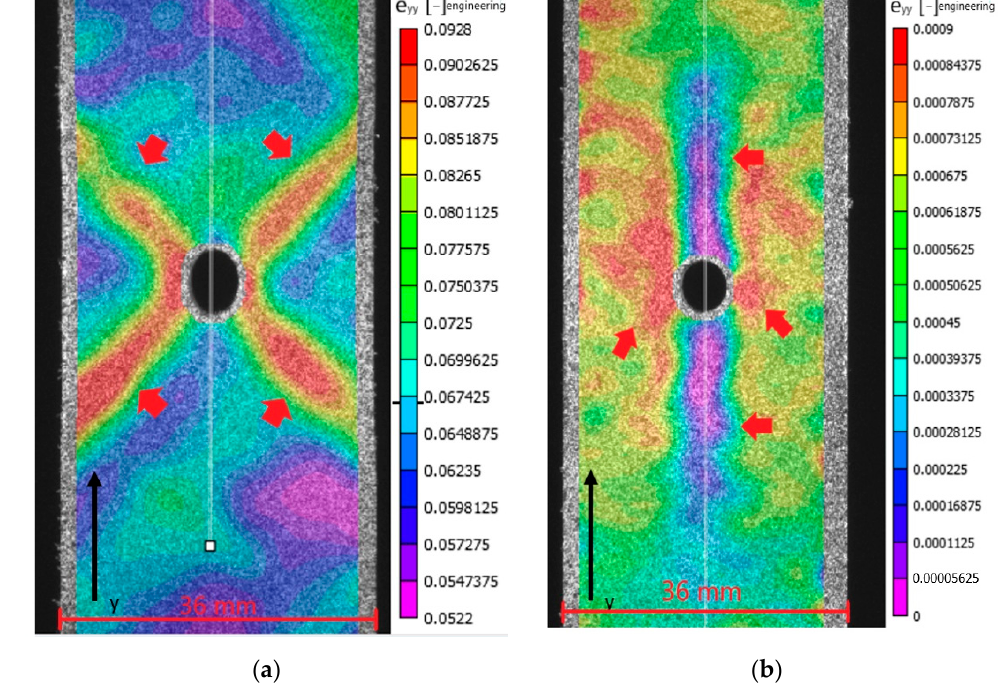
Figure 13. Permanent strain developed after unloading specimen ( a ) LUR-OHT with layup [+45/ − 45] 5s and ( b ) [0/90] 5s after the highest loading cycle before failure.